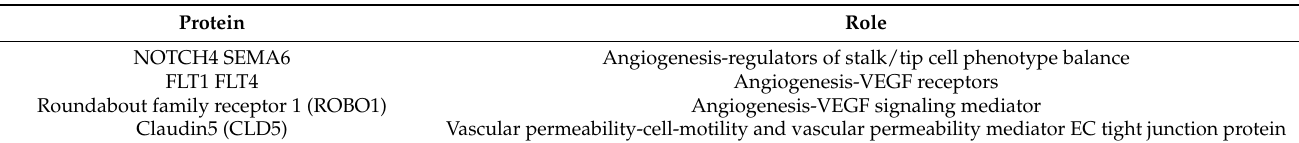
Table 1. Pro-angiogenic factors expressed by type H EC within the developing and growing bone [15]. A brief overview of their known function is